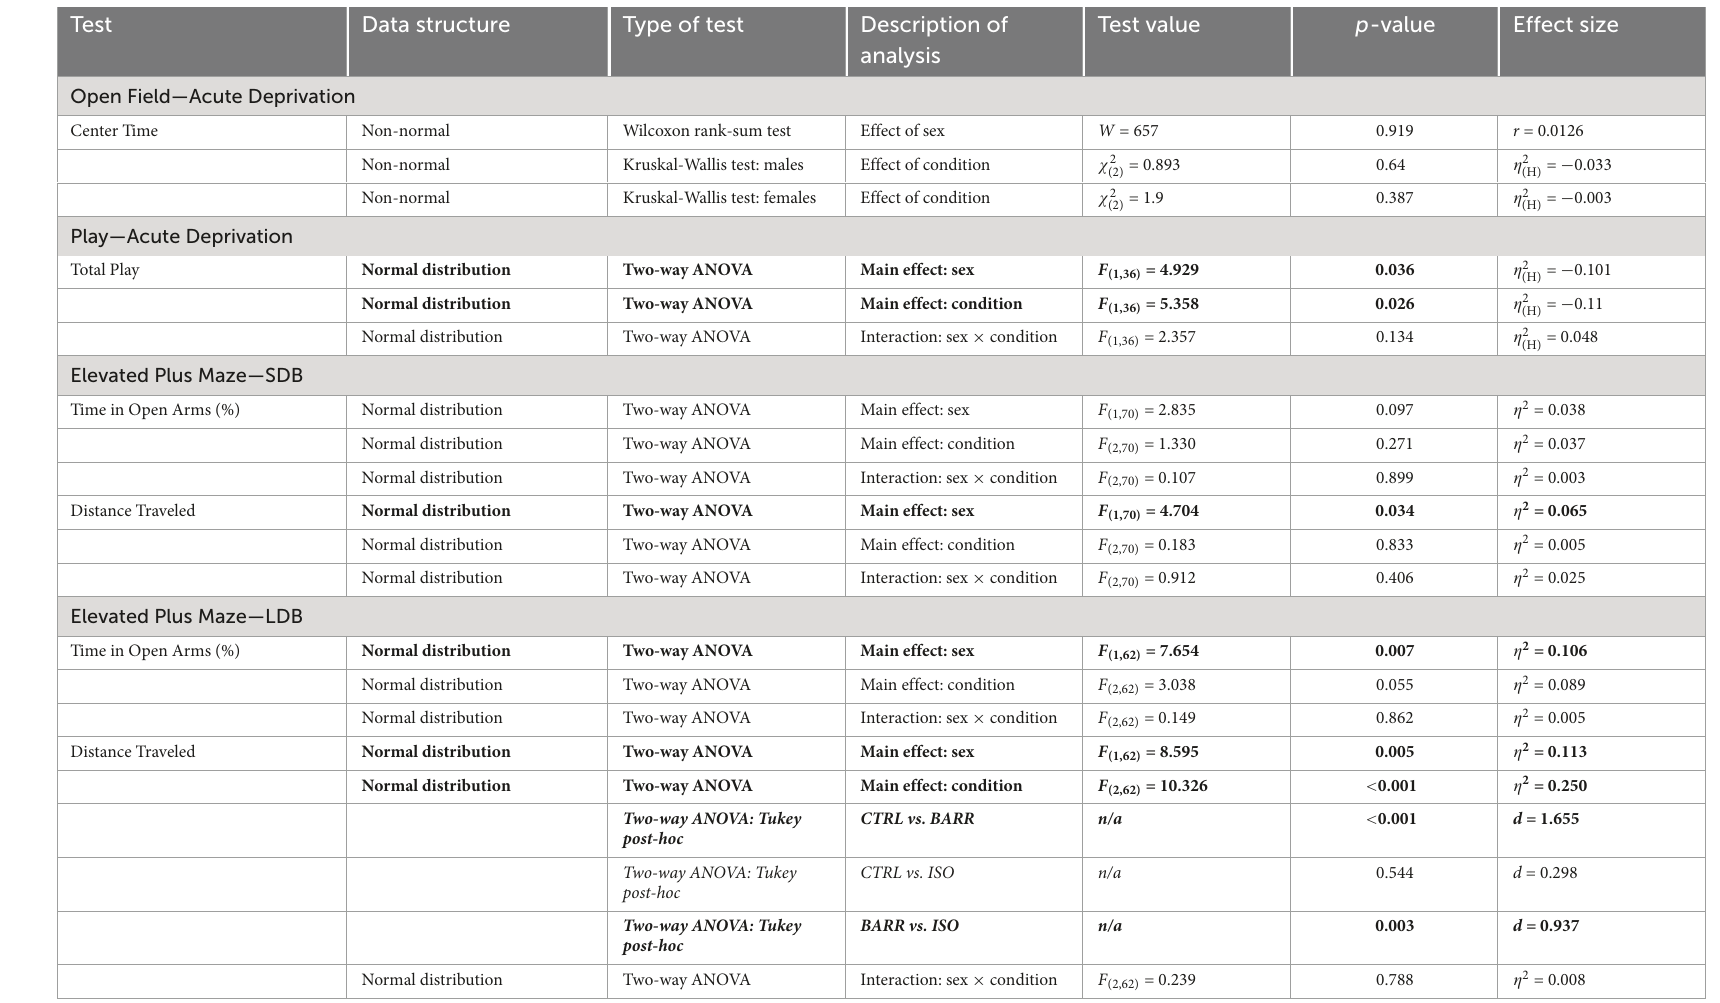
TABLE 1 Summary of statistical